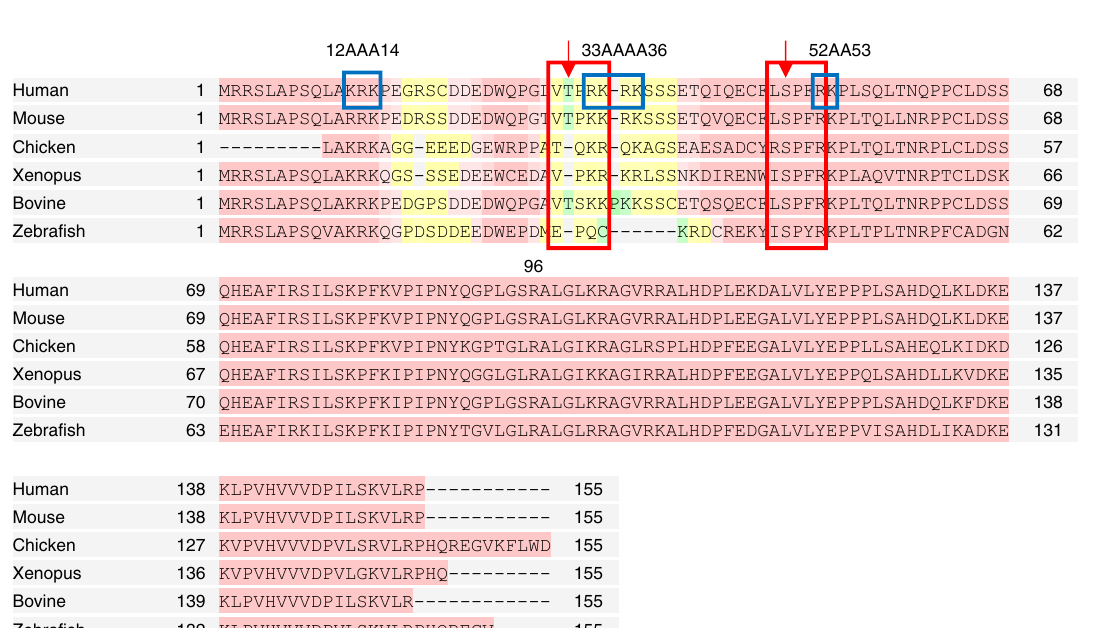
Fig. 1 The Rad54 NTD a.a. sequences from human ( Homo sapiens ), mouse ( Mus musculus ), chicken ( Gallus gallus ), xenopus ( Xenopus tropicalis ), bovine ( Bos taurus ) and zebra fi sh ( Danio rerio ) were analyzed using multiple sequence alignment program, T-coffee 49 . Pink, yellow, and green colored regions show high, low, and very low conservation among sequences, respectively. The red box highlights the CDK2 phosphorylation consensus sequence with arrows pointing to the residue that became phosphorylated. The blue box highlights the basic residues that were mutated to alanines with the name of the mutants indicated above the box. Residue 96 marks the fi rst a.a. residue of the RAD54 96 – 747 truncated